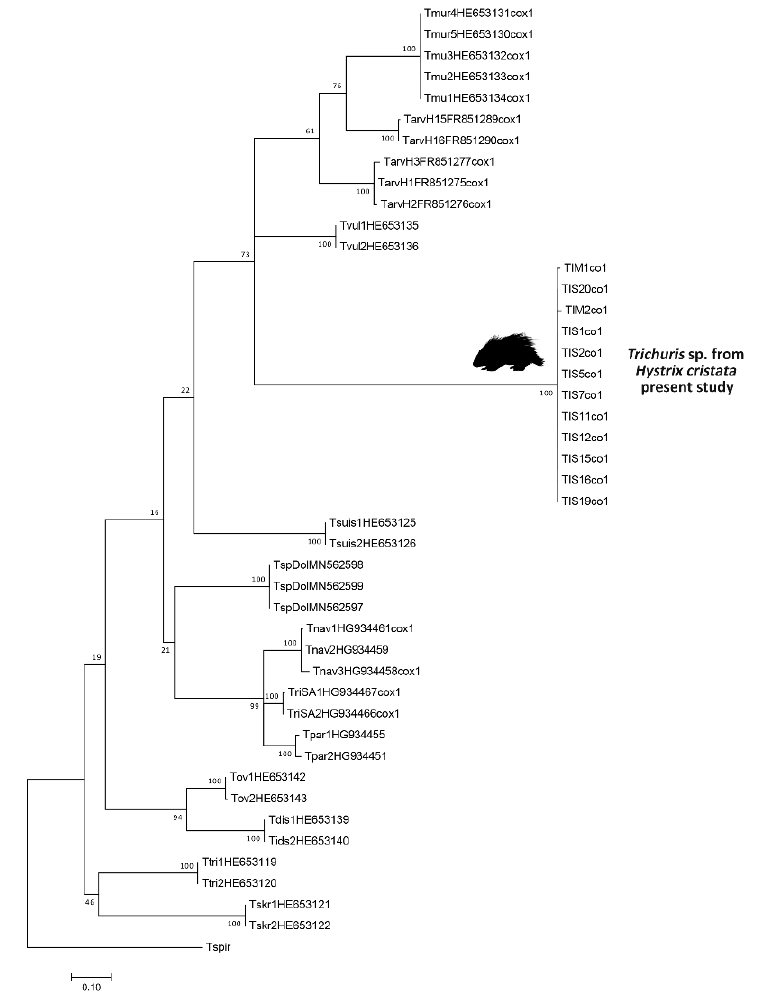
Figure 3. Maximum Likelihood tree based on the analysis of the partial COX1 mitochondrial region, including sequences retrieved from GenBank (cf. Table 1) and sequences of Trichuris sp. analyzed in the present study (TIS and TIM codes). Statistical support values at nodes are reported as bootstrap percentages. Scale bars indicate evolutionary distance.